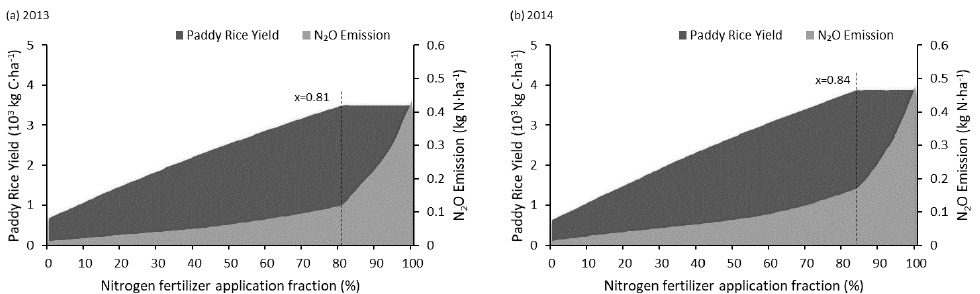
Figure 8. Changes in crop yield and N 2 O emission with different nitrogen fertilization fraction.